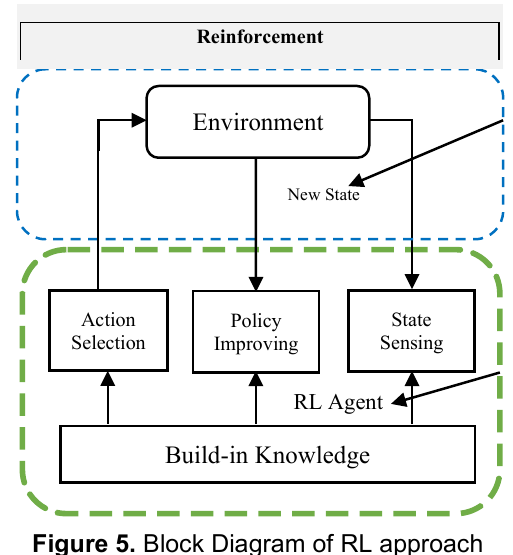
Figure 5. Block Diagram of RL